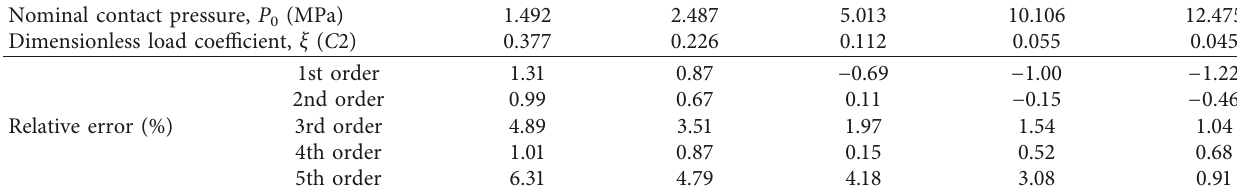
Table 6: Relative errors between the calculated and experimental